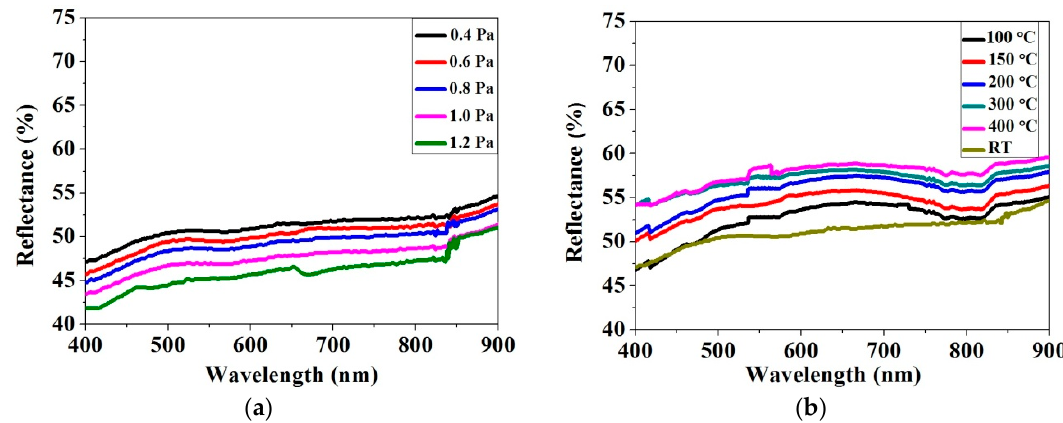
Figure 5. Reflectance of Mo bilayer films ( a ) deposited at different bottom layer sputtering pressures and ( b ) annealed at different temperatures.